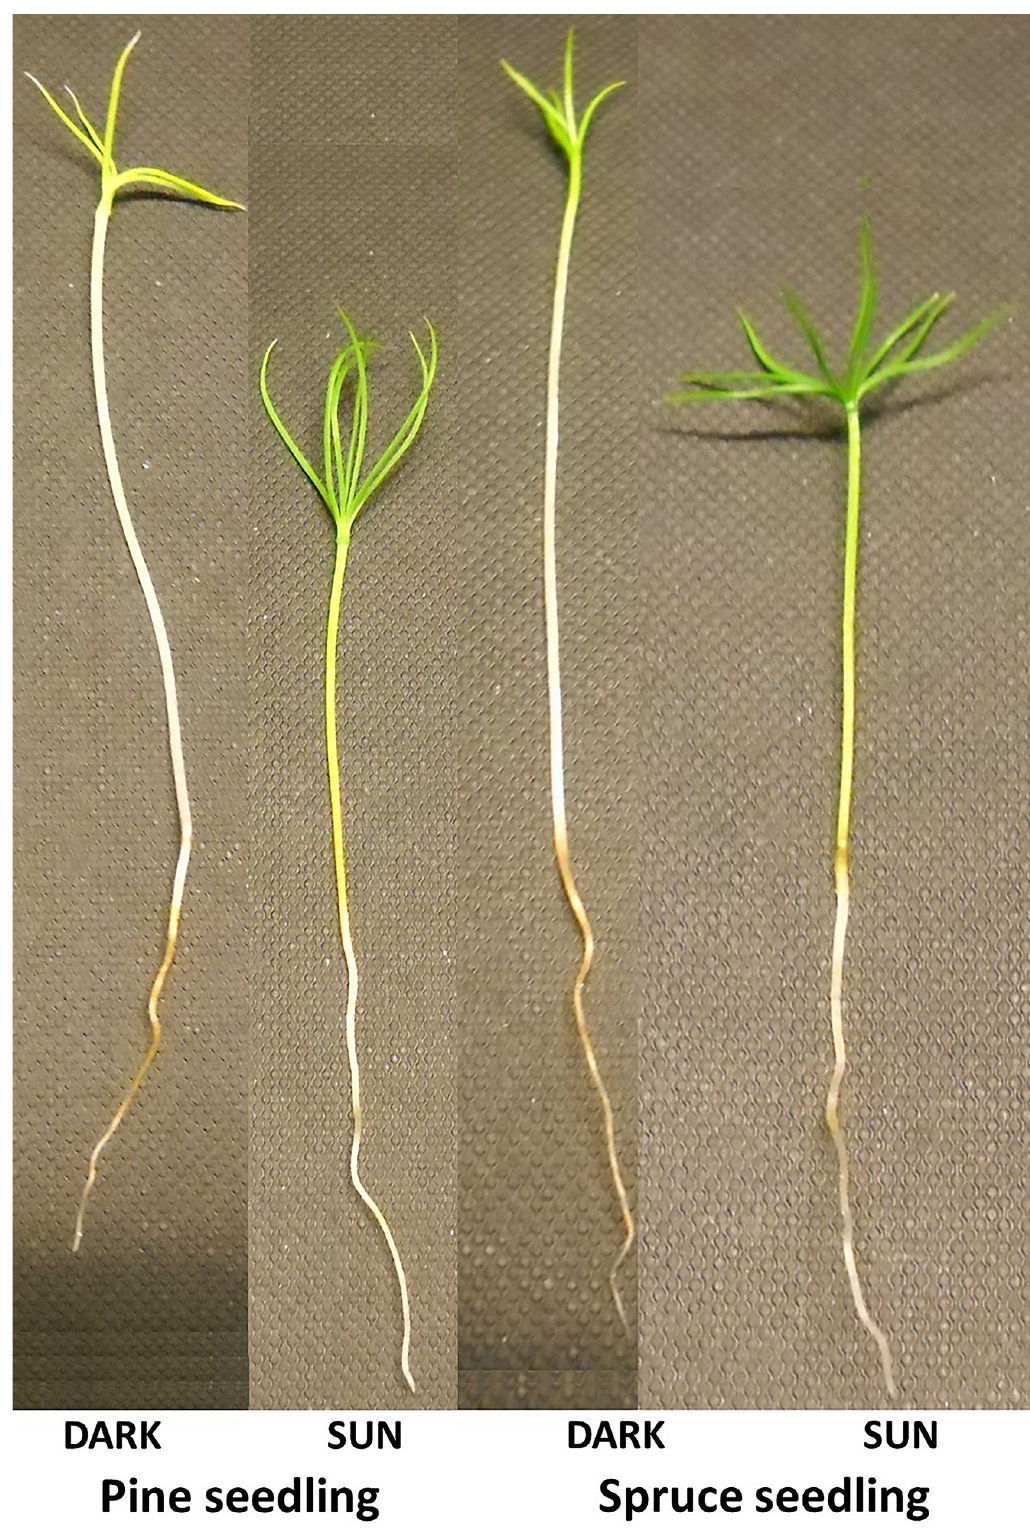
Fig 1. Scots pine and Norway spruce seedlings grown under DARK and SUN–Opening of cotyledons and pale green color due to synthesis of chlorophyll, in seedlings under DARK.